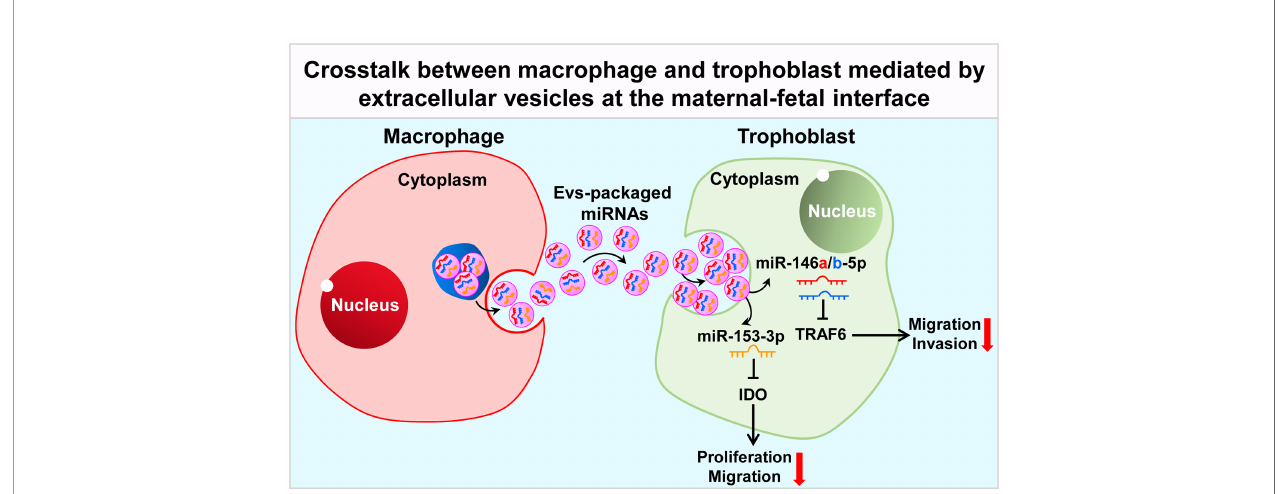
FIGURE 2 | Crosstalk between macrophage and trophoblast mediated by extracellular vesicles at the maternal-fetal interface. Macrophage-derived extracellular vesicles affect the expression of TRAF6 and IDO in trophoblast by delivering miR-146a-5p, miR-146b-5p and miR-153-3p, thereby affecting their invasion and migration capabilities, participating in the pathological process of RSA. TRAF6, TNF receptor associated factor 6; IDO, indoleamine 2,